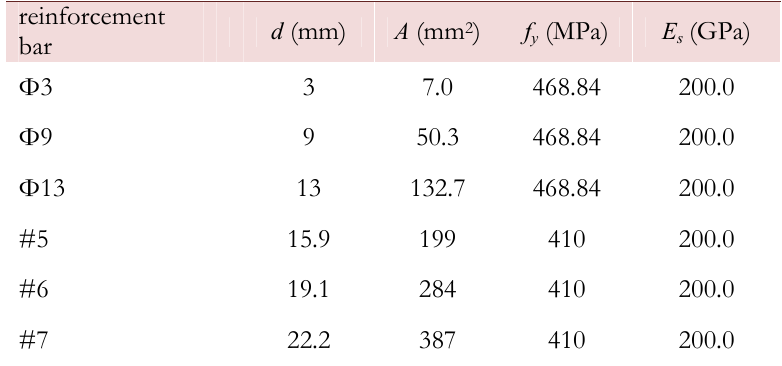
Table 1: Material properties and geometrical data of reinforcement bars of the analysed